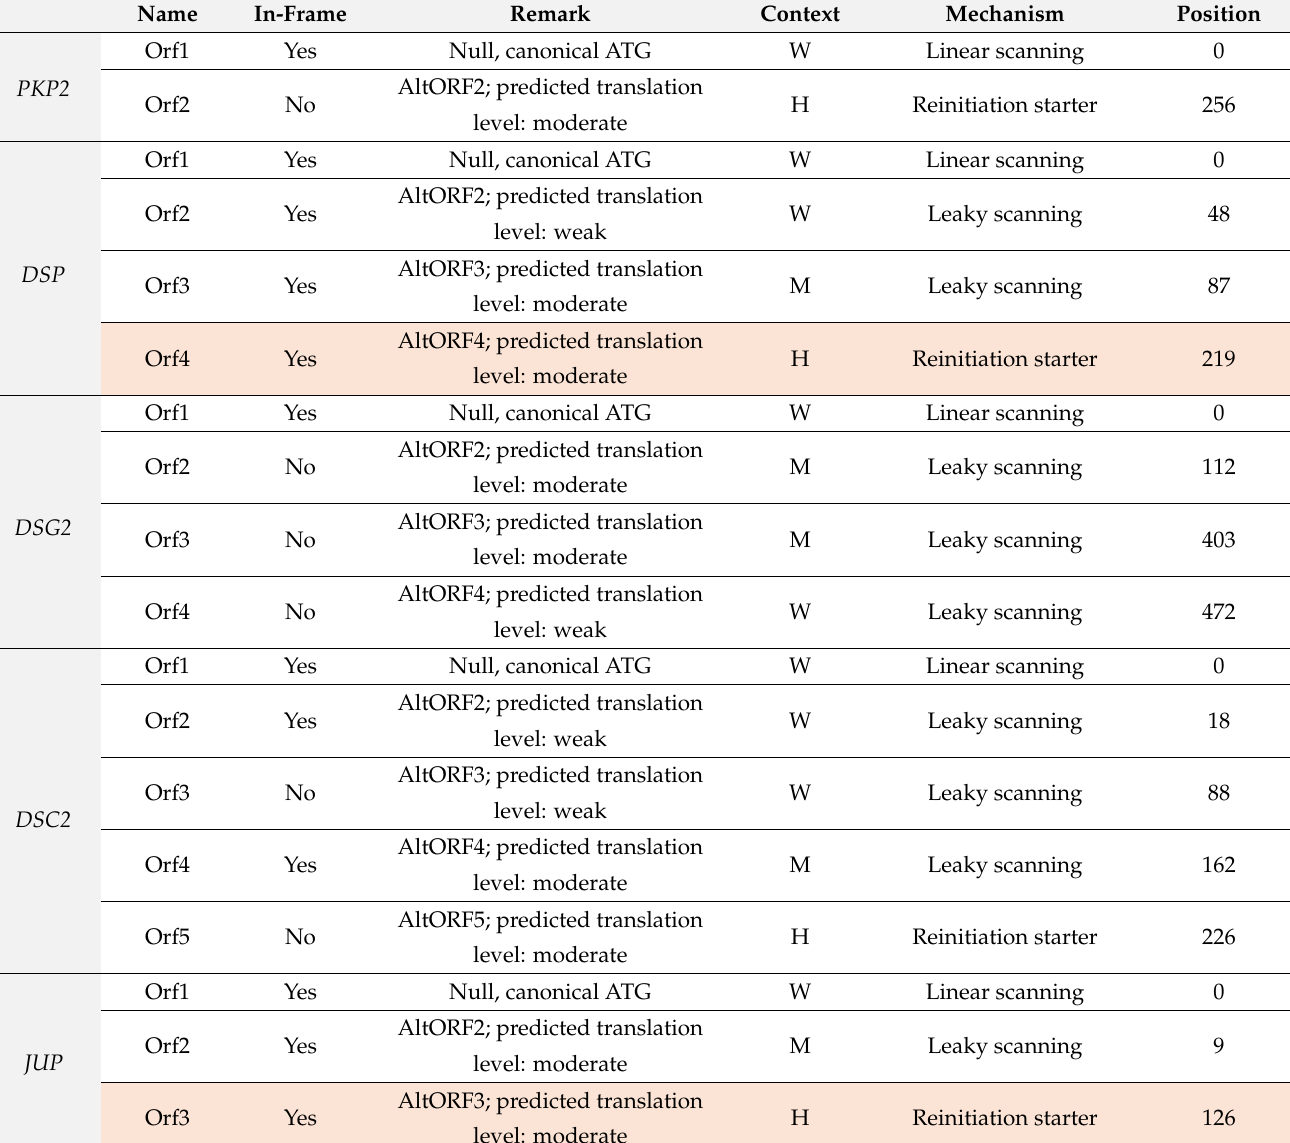
Table 3. In silico prediction of context for translation reinitation of ATGs within the first 160 codons of 5 desmosomal genes: PKP2, DSP, DSG2, DSC2 and JUP . Prediction takes into account all ATGs, in-frame and not. ORFs that start with ATG in-frame and have high genomic context are highlighted in